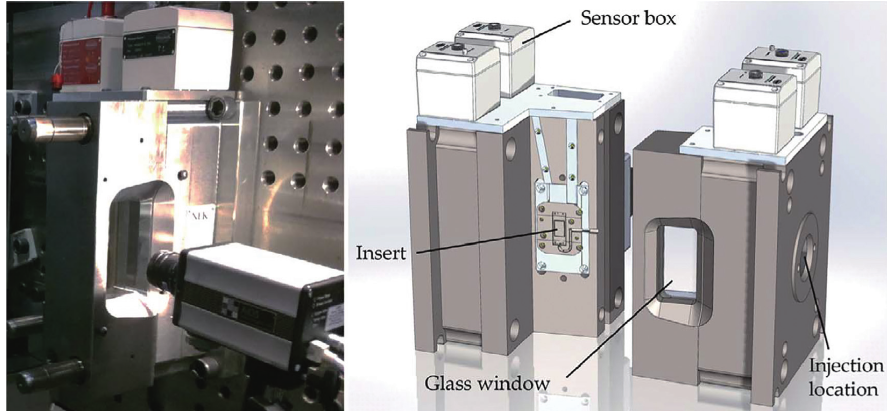
Figure 6: Schematic overview of the visualization mold